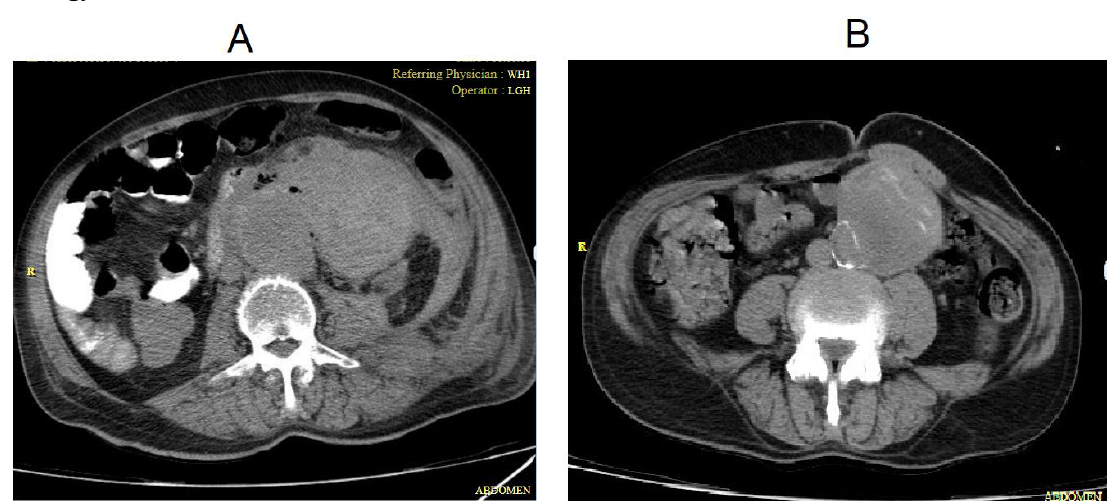
Figure 1 : CT Angiography, A; patient 1, B; patient 2.